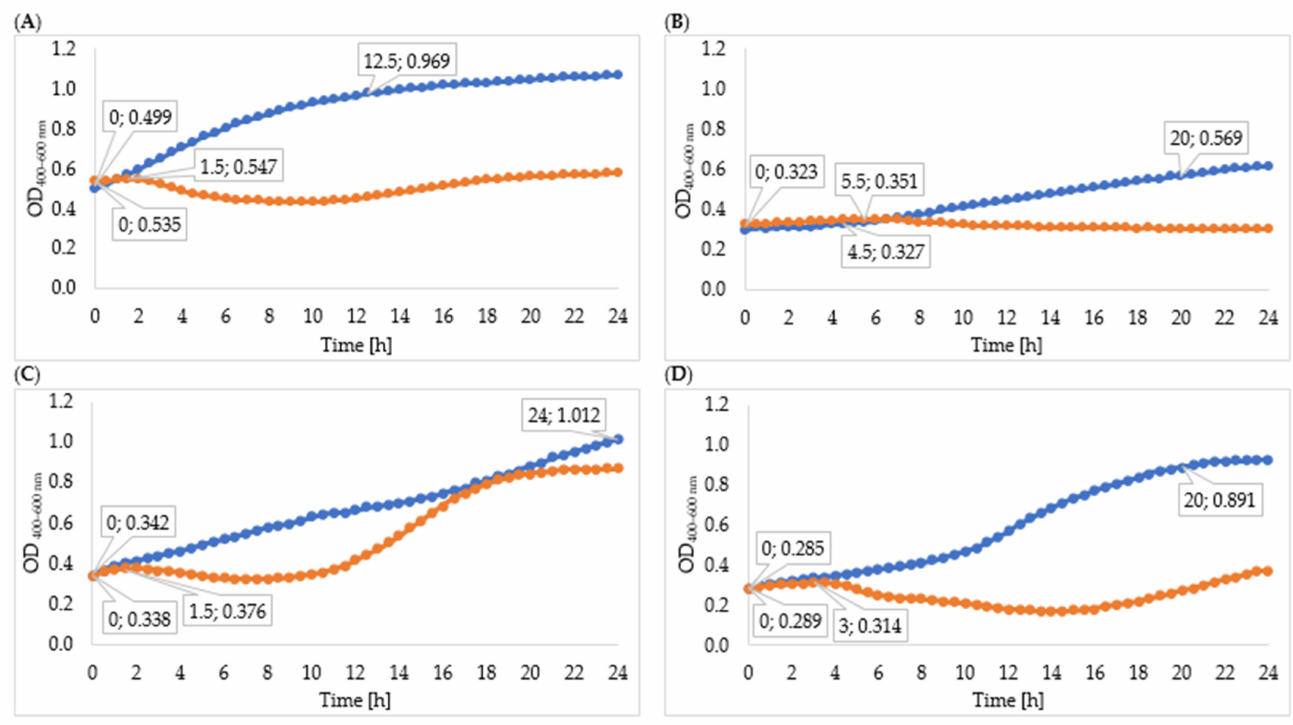
Figure 2. Growth curves of tested bacteria: